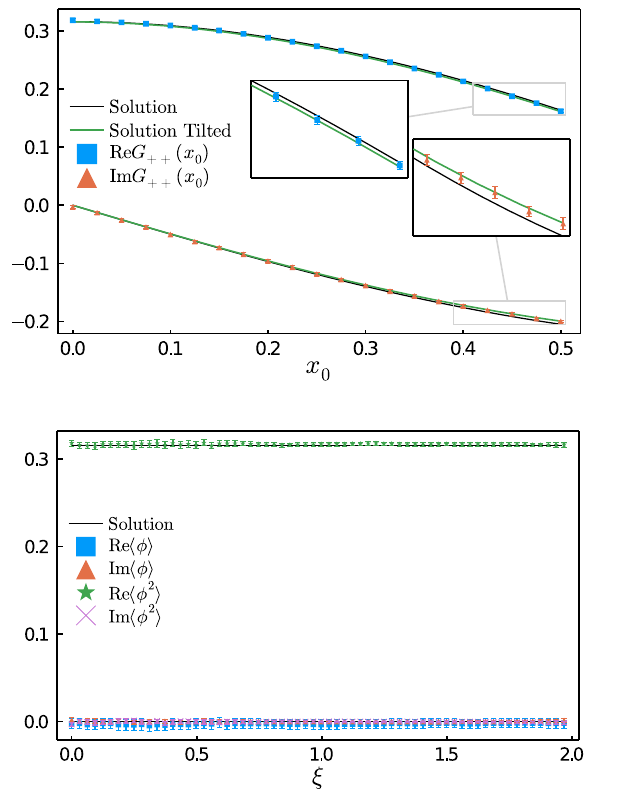
Figure 4 . Simulation results for the anharmonic oscillator based on the semi-implicit Euler- Maruyama scheme on a 0 . 01 β tilted contour: (top) unequal-time correlation function G ++ ( x 0 ) = h φ (0) φ ( x 0 ) i − h φ (0) ih φ ( x 0 ) i plotted for real-time values along the forward branch of the tilted Schwinger-Keldysh contour together with the true solution on the real-time axis (black solid) and along the tilted contour (green solid). Close to x 0 = 0 . 5 our simulation can already distinguish between the two. (bottom) The field expectation value h φ i and the equal-time correlation function h φ 2 i evaluated on both branches. Agreement with the true solution is observed within uncertainty (errors appear larger here only since the y-axis scale is reduced compared to the top